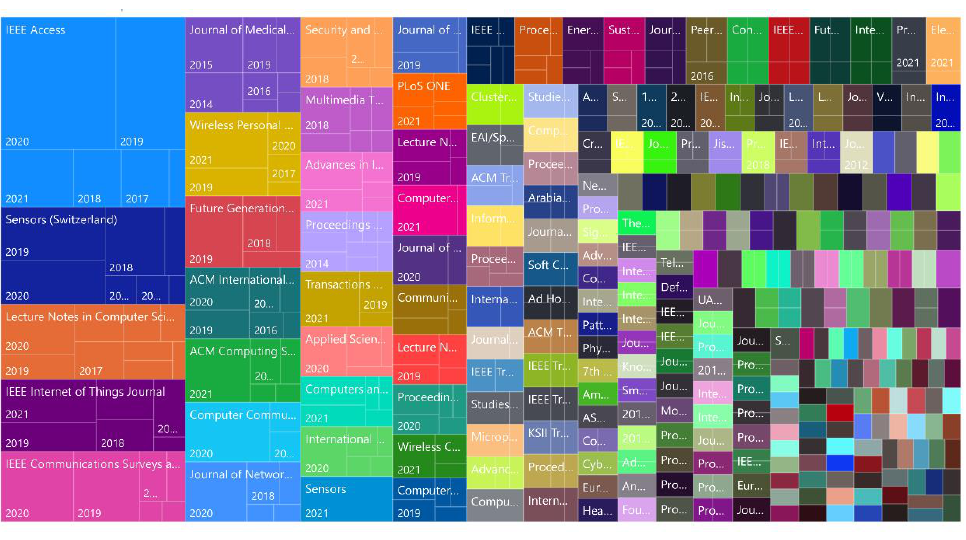
Figure 3. Physical layer attack search from PubMed and WoS categorized by research field.